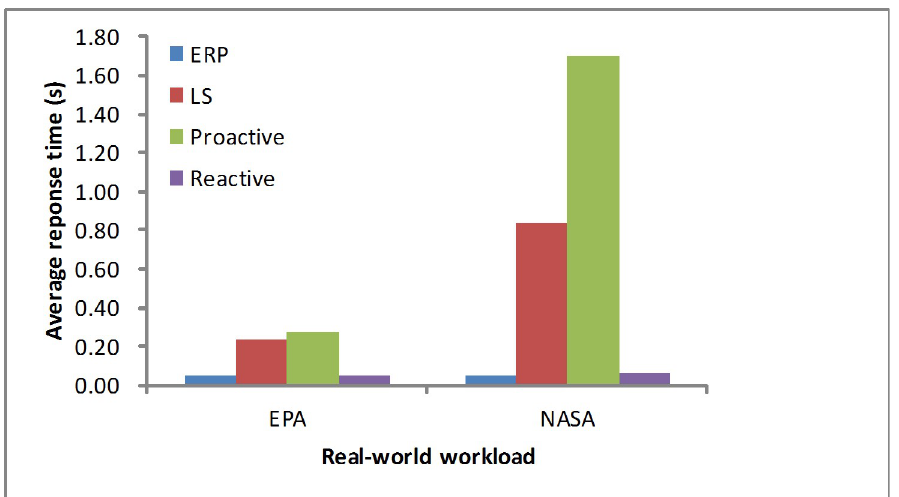
Fig 15. Average response time in the real-world workloads.